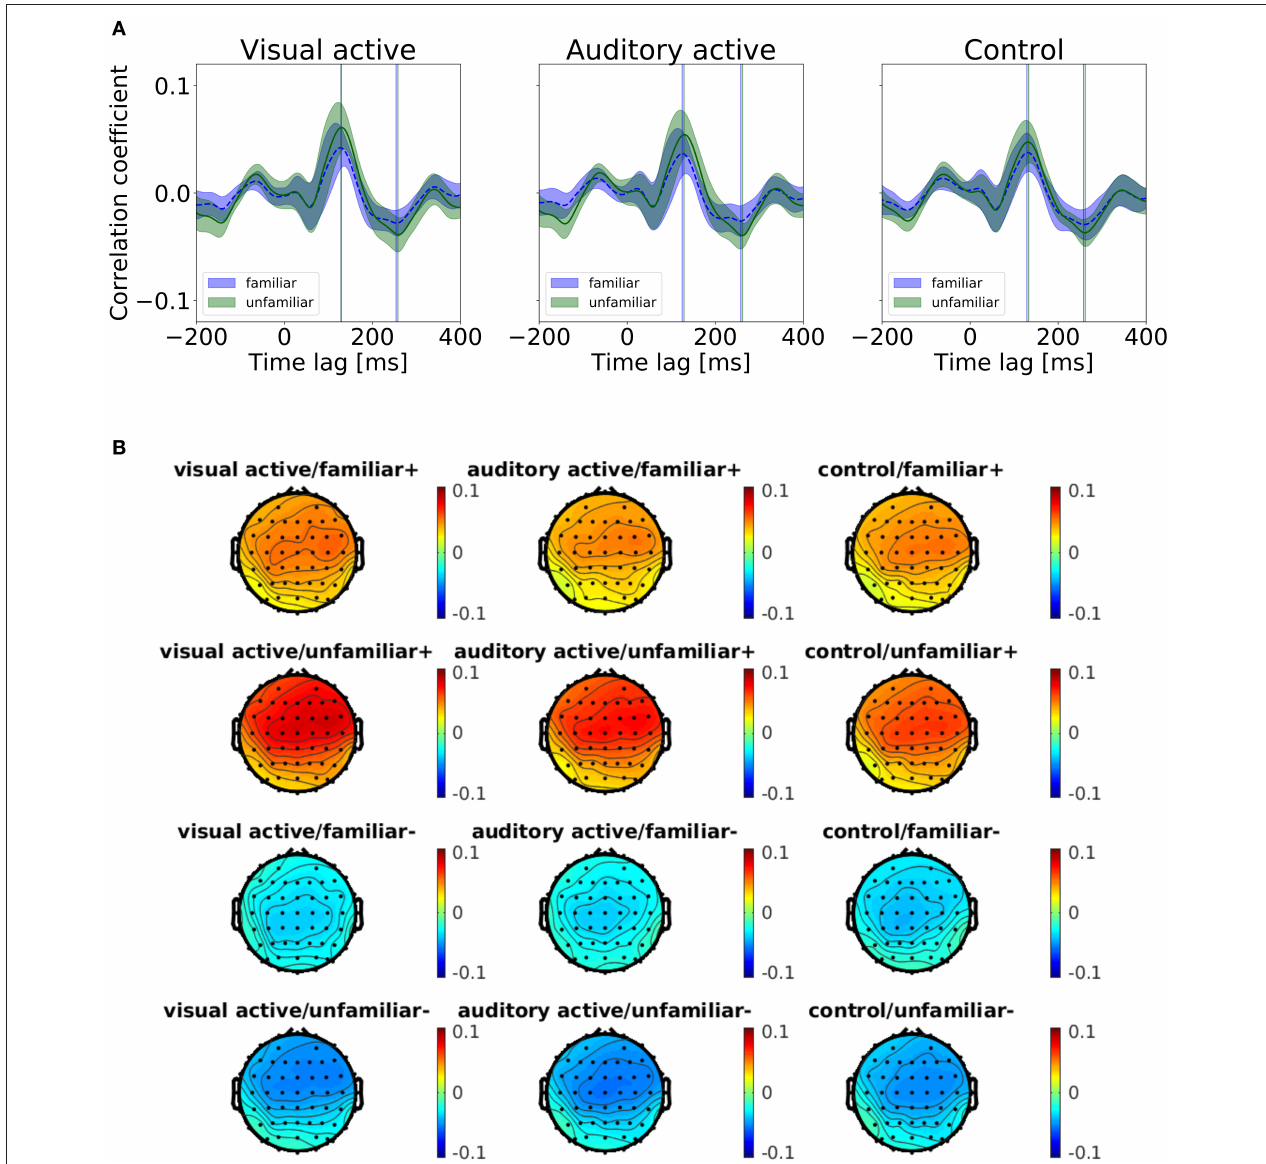
FIGURE 4 | (A) Results of the cross-correlation values averaged across the channels. Cross-correlation values between the envelopes of the sound stimuli and the EEGs averaged across the trials and participants for the task and the level of familiarity. The solid line indicates the grand average of the cross-correlation values across channels. The shaded region indicates the standard error. The vertical lines indicate the maximum (i.e., positive peaks) and the minimum (i.e., negative peaks) of the cross-correlation values of the averaged cross-correlation functions. (B) Each subfigure shows the peaks at the time lags around 130 and 260 ms. The topographies show the distribution of the cross-correlation values at the positive ( + ) and negative ( − ) peaks.